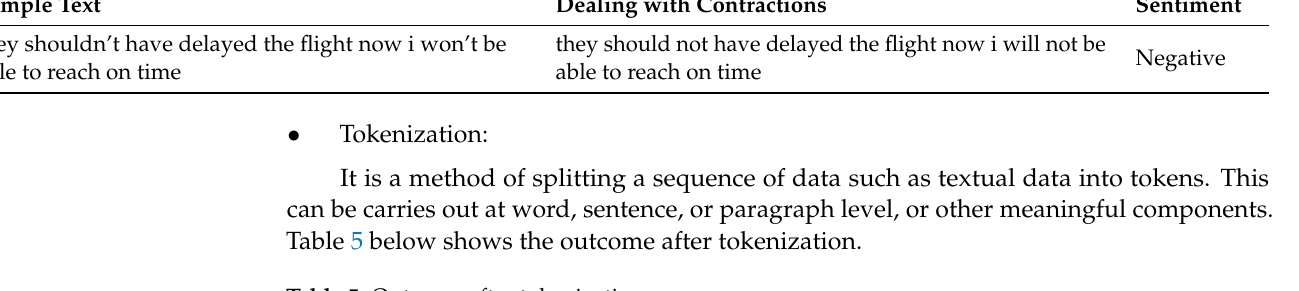
Table 5. Outcome after